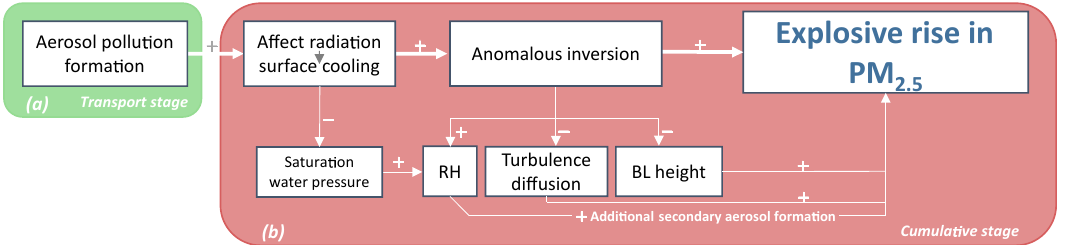
Figure 8. A schematic figure of the formation mechanism for winter heavy-pollution episodes in Beijing, which consist of the transport stage (green background) and the cumulative stage (red